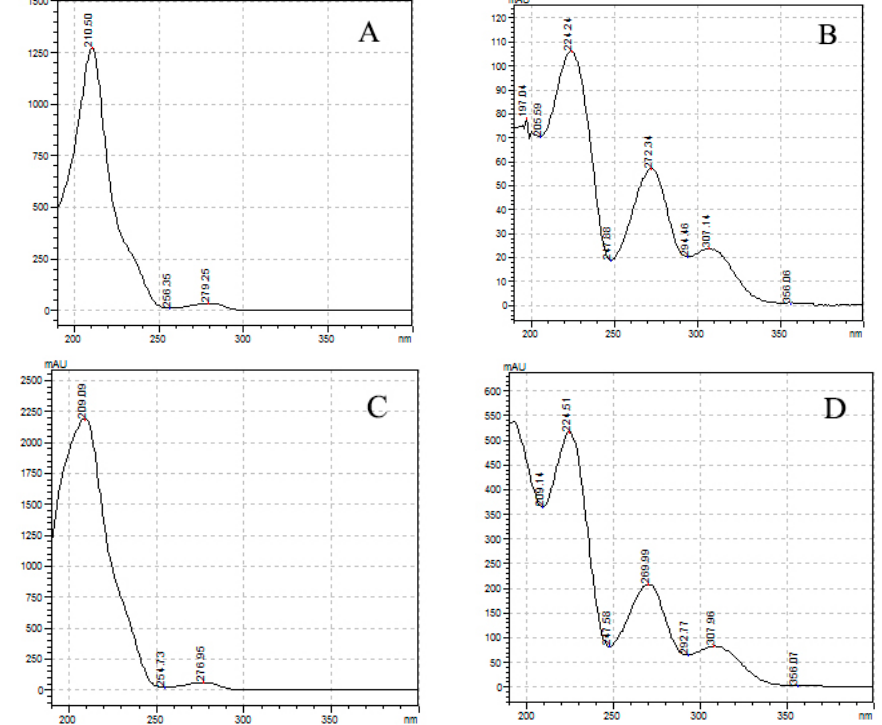
Figure 2. UV (ultraviolet) spectrum of four main cannabinoids. ( A ) ∆ 9-tetrahydrocannabinol, ( B ) ∆ 9-tetrahydrocannabinolic acid, ( C ) cannabidiol, and ( D ) cannabidiolic acid. Analysis was carried out from 190 nm, the lowest detection wavelength of the instrument.